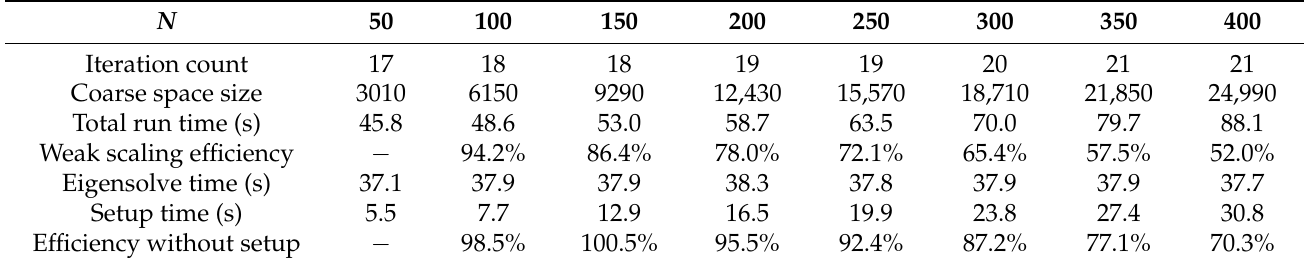
Table 11. Weak scaling results and timings for the alternating layers problem when using ORAS with H-GenEO ( 1 ) and a varying number of subdomains for k = 73.8, h − 1 = 800 and ρ = 100. A uniform 2 decomposition into N = 25 L subdomains is used, as depicted in Figure 5. Note that setup refers to the initial decomposition and partitioning, which is performed sequentially, while the local problems and eigensolves are carried out in